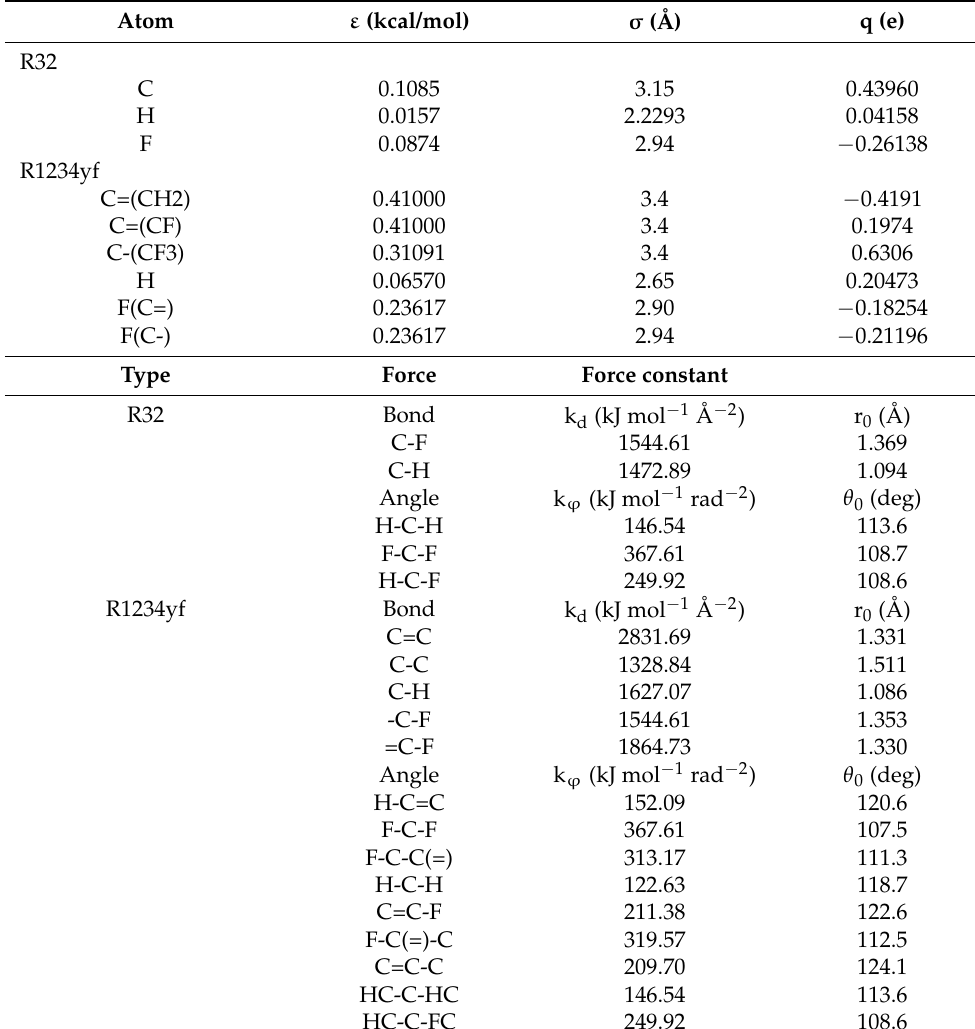
Table 2. Force field parameters for R32,